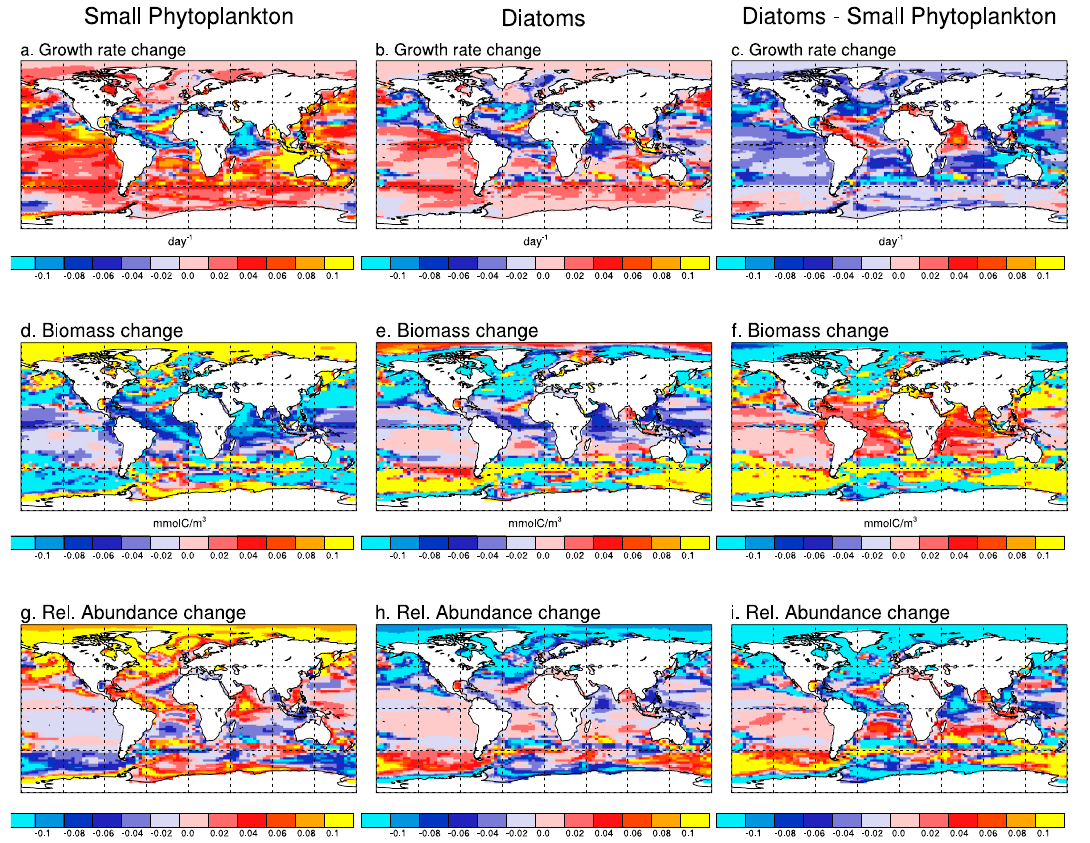
Fig. 5. Climate model predicted 1980–2100 changes in: (a, b, c) specific growth rate in day − 1 ; (d, e, f) biomass in mmol C/m 3 ; (g, h, i) fractional abundance – no units – for small phytoplankton (left panels), diatoms (middle panels), and the difference between diatoms and small phytoplankton (right hand panels). Specific growth rate change 1µ x calculated from the 1980–2100 linear trend multiplied by 120